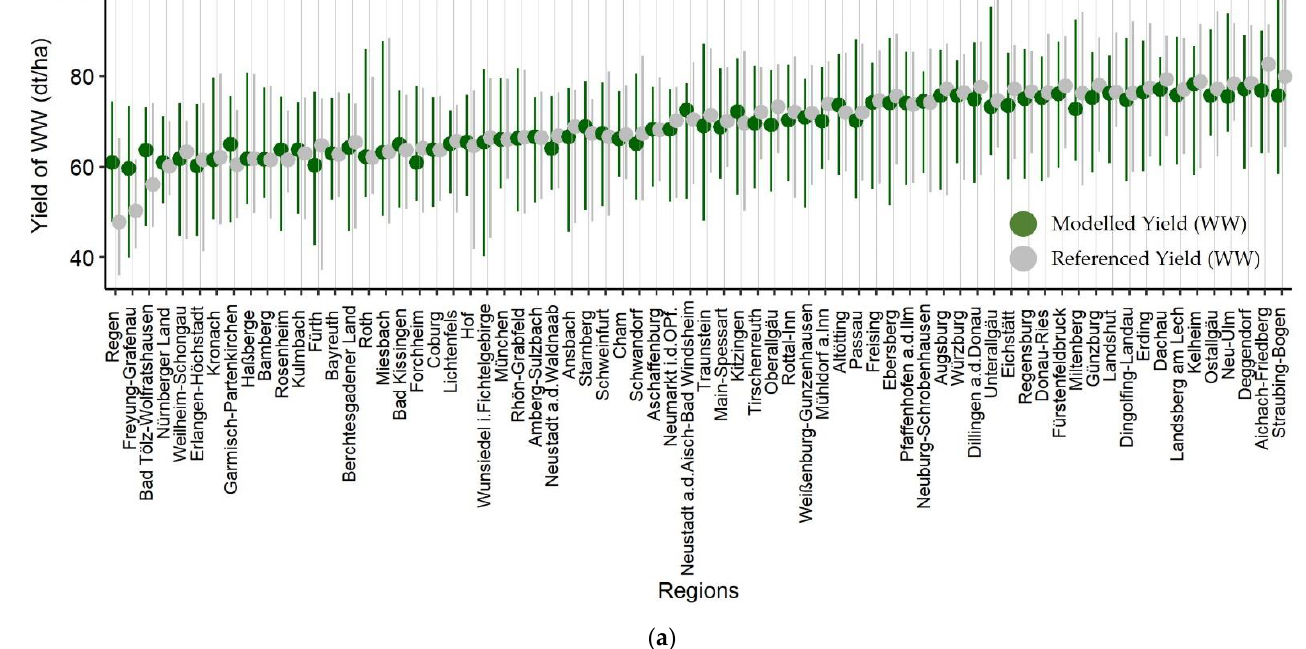
Figure 11. Spatial distribution of mean referenced yield (2001 – 2019) and the year-wise predicted yield for OSR from 2001 to 2019 using the LUE model for the state of Bavaria. The white colour rep- resents no available data. A detailed map of the administrative regions of Bavaria is shown in Figure A1.